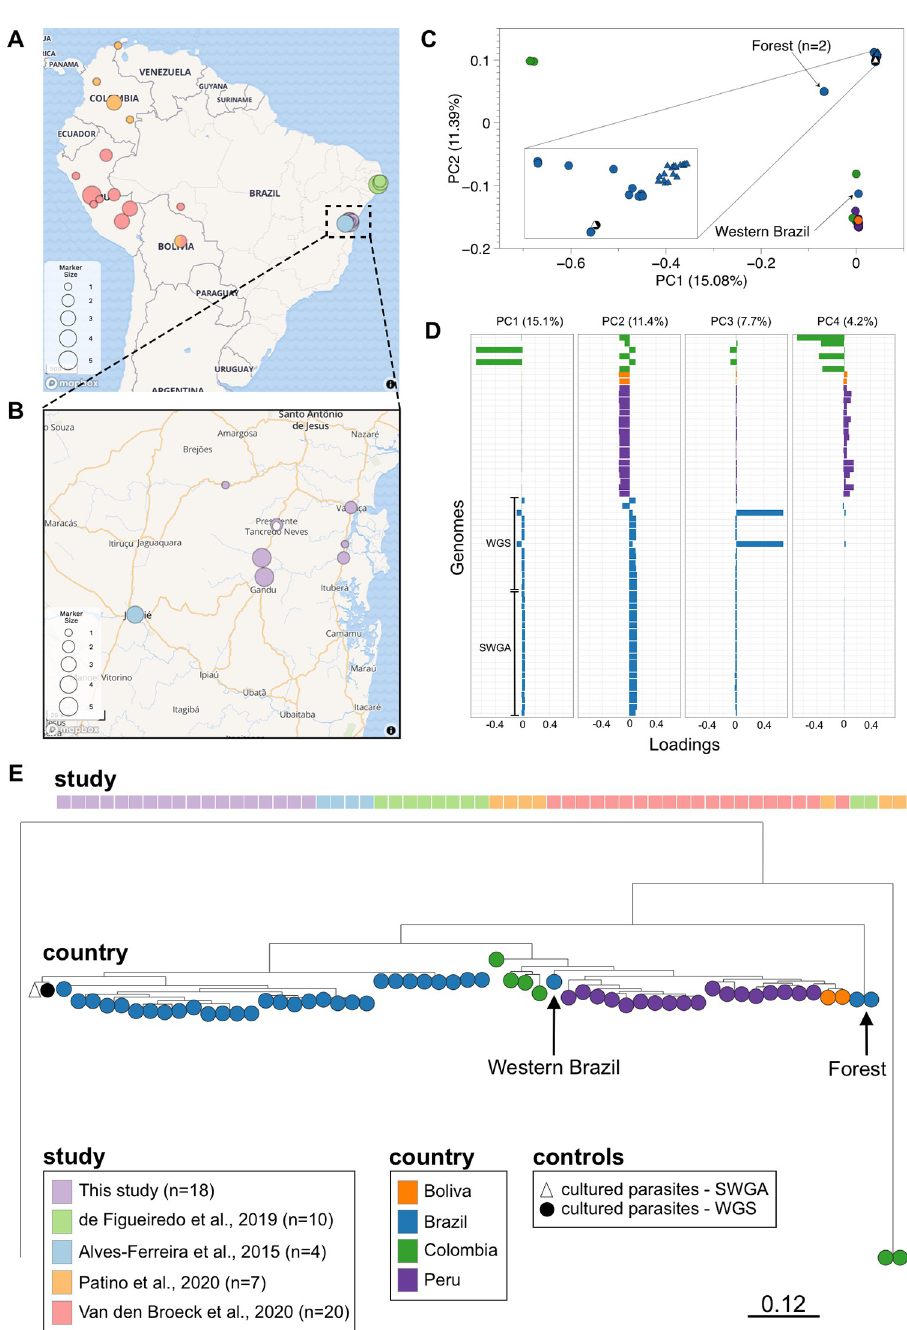
Fig 5. Integrating SWGA and WGS genomes for population genomics. (A) Map showing all 59 samples, from this study and four previously published reports, included in the analysis [7, 46, 8, 47]. (B) Zoomed in view of Bahia, Brazil showing region covered by samples from this study. White point indicates position of field hospital where patients were seen. (C-D) Principal component analysis of SNP data from 59 genomes, colored by country of origin. (E) Maximum likelihood tree constructed using 877713 variants from 59 L . braziliensis genomes and the L . guyanensis outgroup, compared to the L . braziliensis reference. Branch length of outgroup was shortened for figure preparation. Tree is rooted using the L . guyanensis outgroup. The same cultured laboratory clone of L . braziliensis from Brazil was sequenced either by traditional WGS (black circle) or SWGA (white triangle) . Map data from Maps Mapbox (www. mapbox.com/about/maps) and OpenStreetMap (www.openstreetmap.org/about).